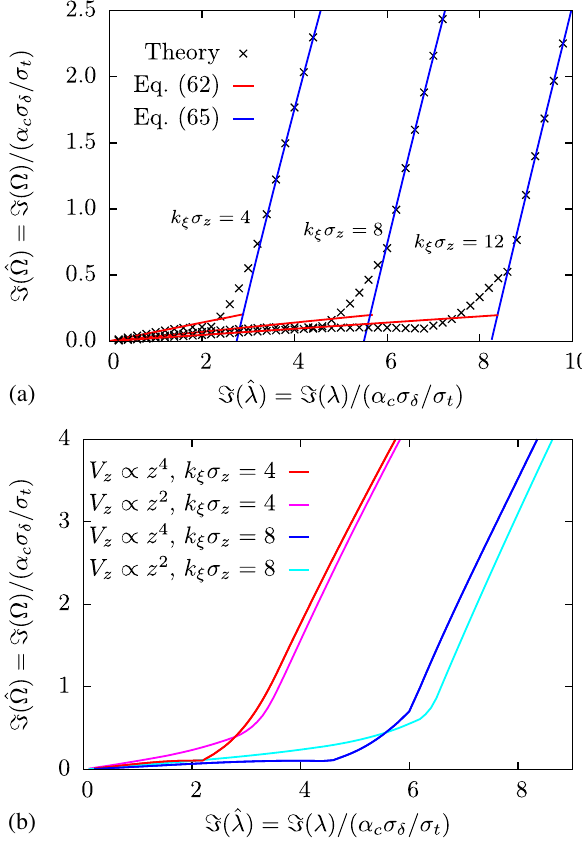
FIG. 6. (a) Theoretically predicted growth rates for the quartic potential as a function of the ξ ¼ 0 growth rate ℑ ð λ Þ . Crosses are the full theory, while the red and blue lines represent the weak and strong instability limits, respectively. (b) Comparison of the growth rates between the quartic (red and blue) and the quadratic (magenta and cyan) longitudinal potentials, for two different values of the